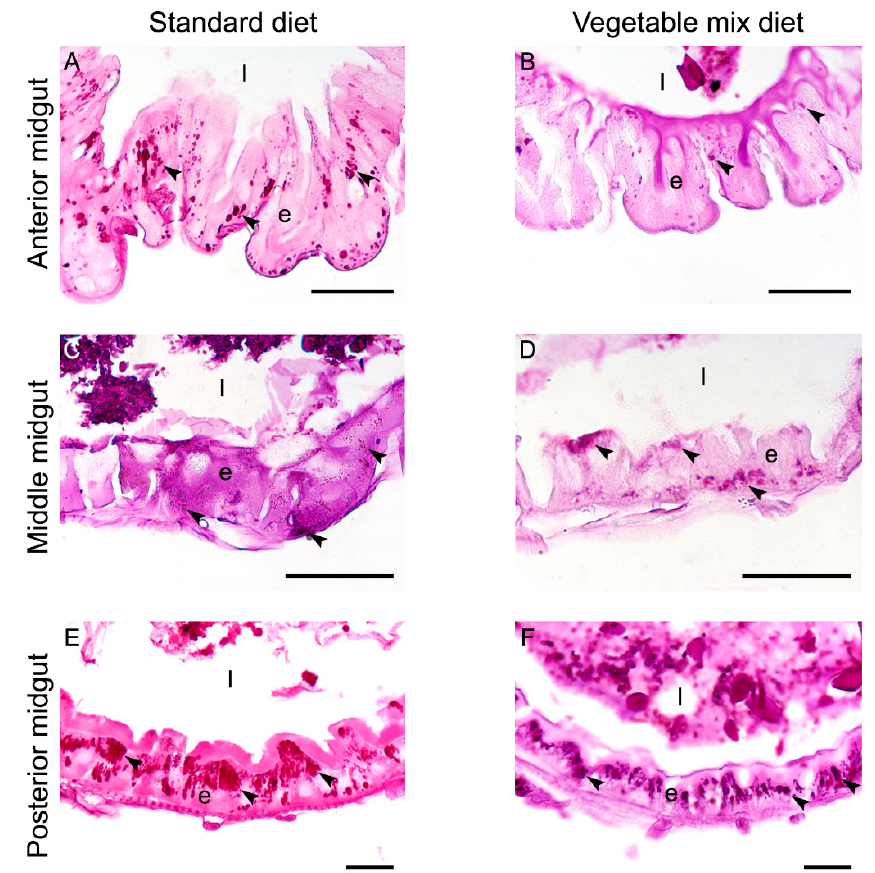
Figure 4. Comparison of glycogen accumulation in the three midgut regions of larvae reared on SD and VMD—Periodic Acid-Schiff (PAS) staining. ( A , B ): anterior midgut of larvae reared on SD ( A ) shows a higher accumulation of glycogen (arrowheads) than VMD ( B ). ( C – F ): middle ( C , D ) and posterior ( E , F ) midgut of larvae reared on the two diets do not show significant differences in glycogen accumulation. e: epithelium; l: lumen. Bars: 50 μ m ( A , B , E , F ), 20 μ m ( C , D ).